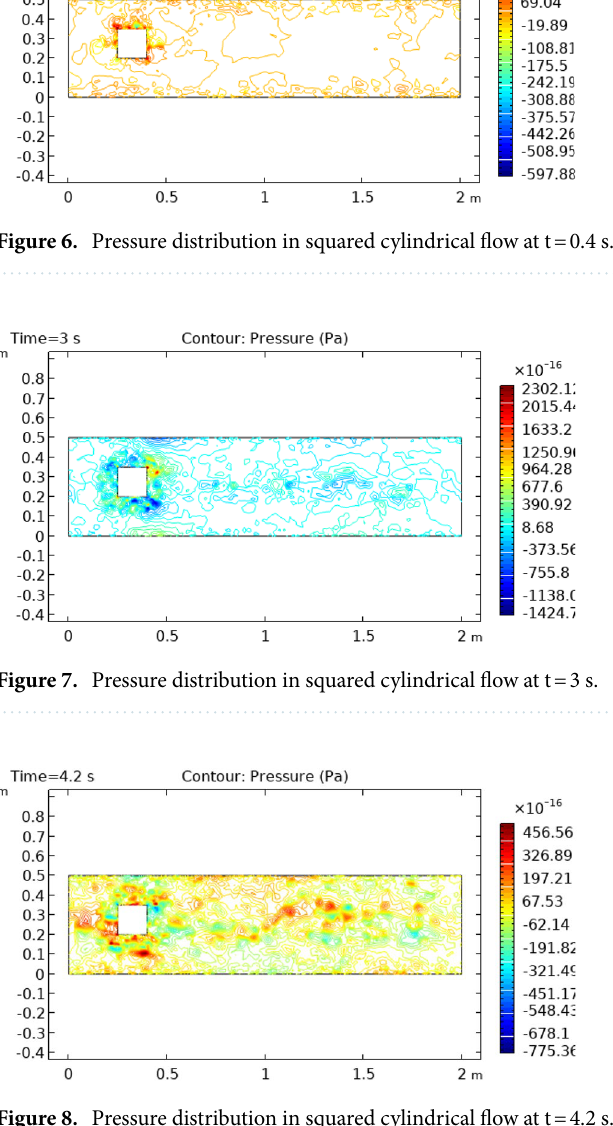
Figure 8. Pressure distribution in squared cylindrical flow at t = 4.2